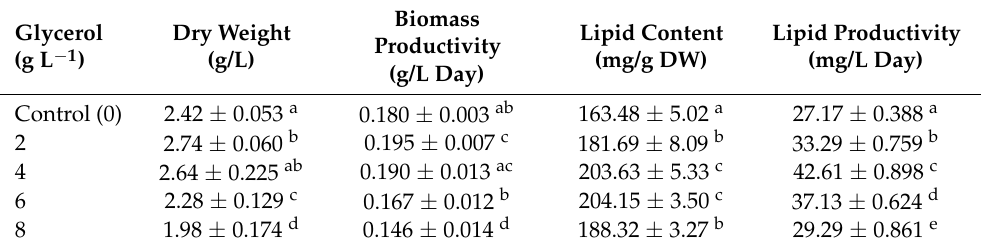
Table 3. Effect of different concentrations of glycerol on biomass and lipids of Chlorella sp. cultivated in synthetic wastewater and harvested at the late exponential phase.